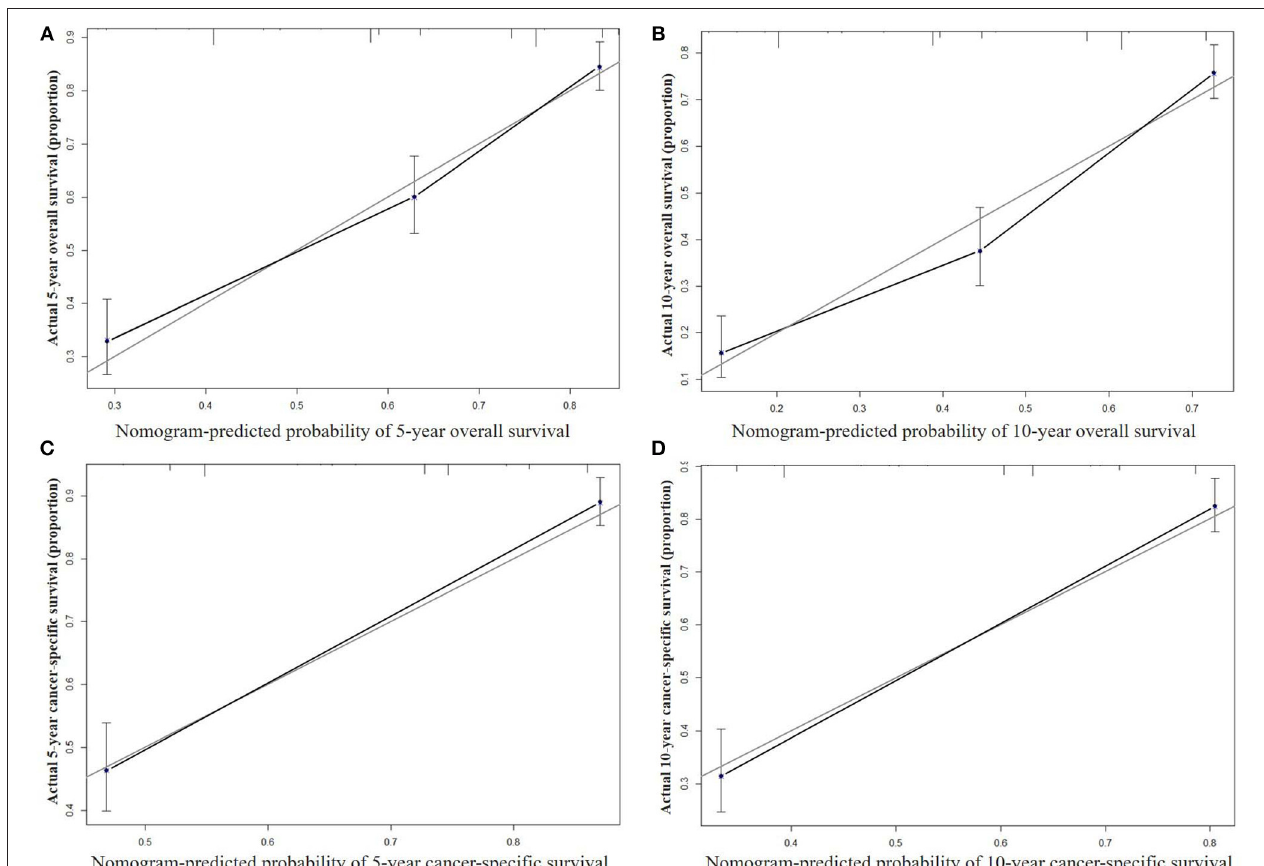
FIGURE 4 | External calibration curves for 5-year (A) and 10-year (B) overall survival; and 5-year (C) and 10-year (D) cancer-specific survival. The X axis represents the nomogram predicted survival rate, whereas the Y axis represents the actual survival